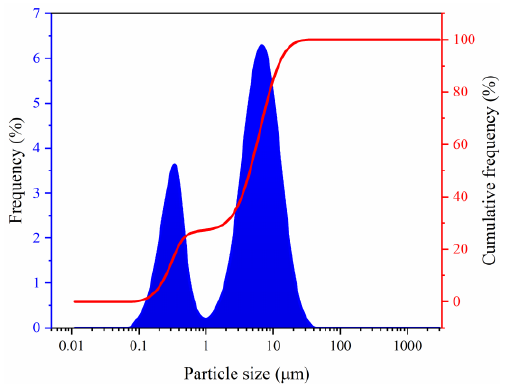
Figure 2. Particle size distribution of sediments. Table 1. Mineral composition of sediment.